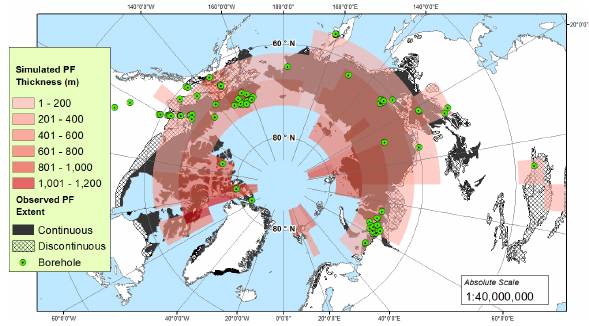
Figure 10. Map of deep Global Terrestrial Network for Permafrost (GTN-P) borehole locations with the simulated permafrost thick- ness (with snow enhancement) and observed permafrost extent (Brown et al.,